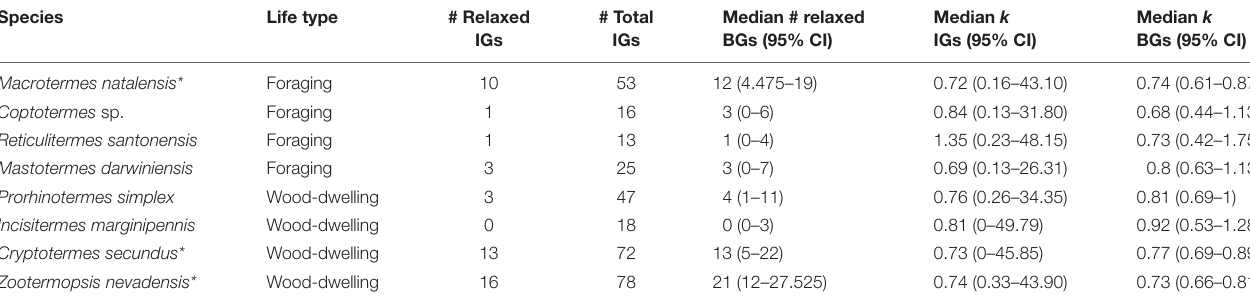
TABLE 1 | Results of RELAX analyses of changes in selection intensity on termite immune genes (IGs).